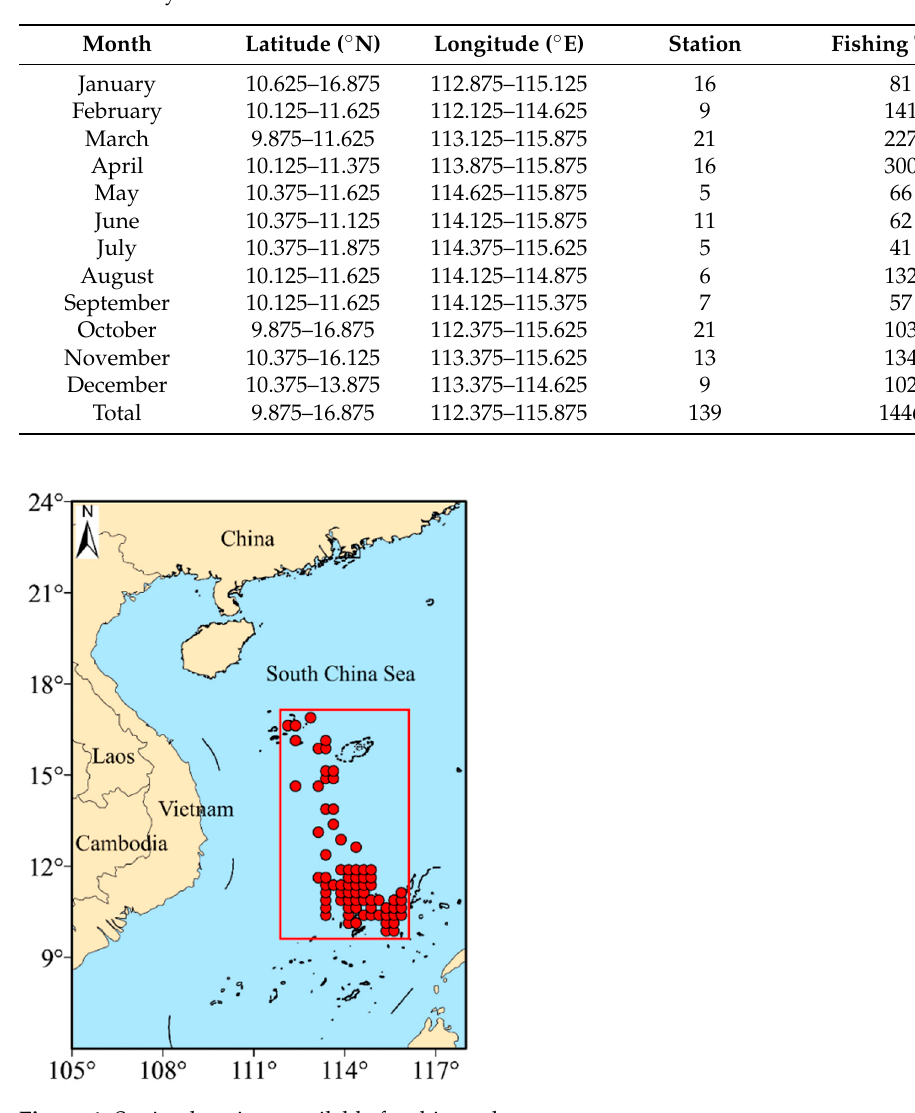
Figure 1. Station locations available for this study.